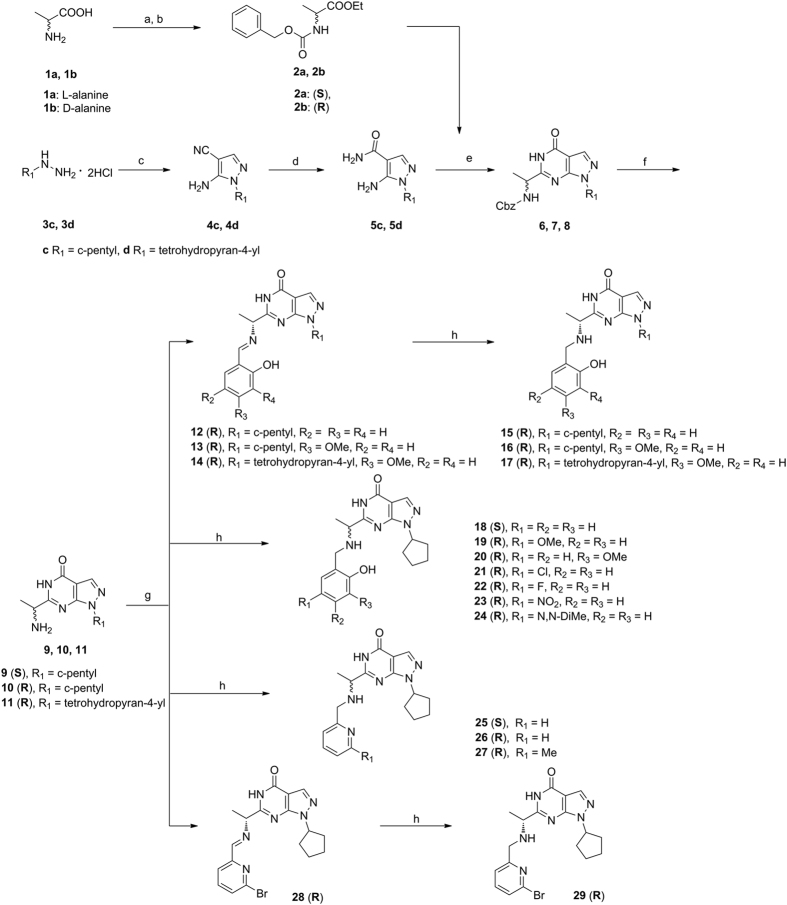
The synthesis of compounds 12–29.Reagents and conditions: (a) SOCl2, ethanol, reflux; (b) Benzyl chloroformate, Na2CO3, H2O, rt; (c) 2-(ethoxymethylene)malononitrile, Et3N, ethanol, rt to reflux; (d) 35% aq H2O2, aq ammonia, ethanol, rt; (e) 2a or 2b, NaH (80%), THF, rt; (f) Pd/C (10%), H2, MeOH; (g) substituted salicylaldehyde or substituted 2-pyridylaldehyde, MeOH, rt; (h) NaBH4, MeOH, rt.